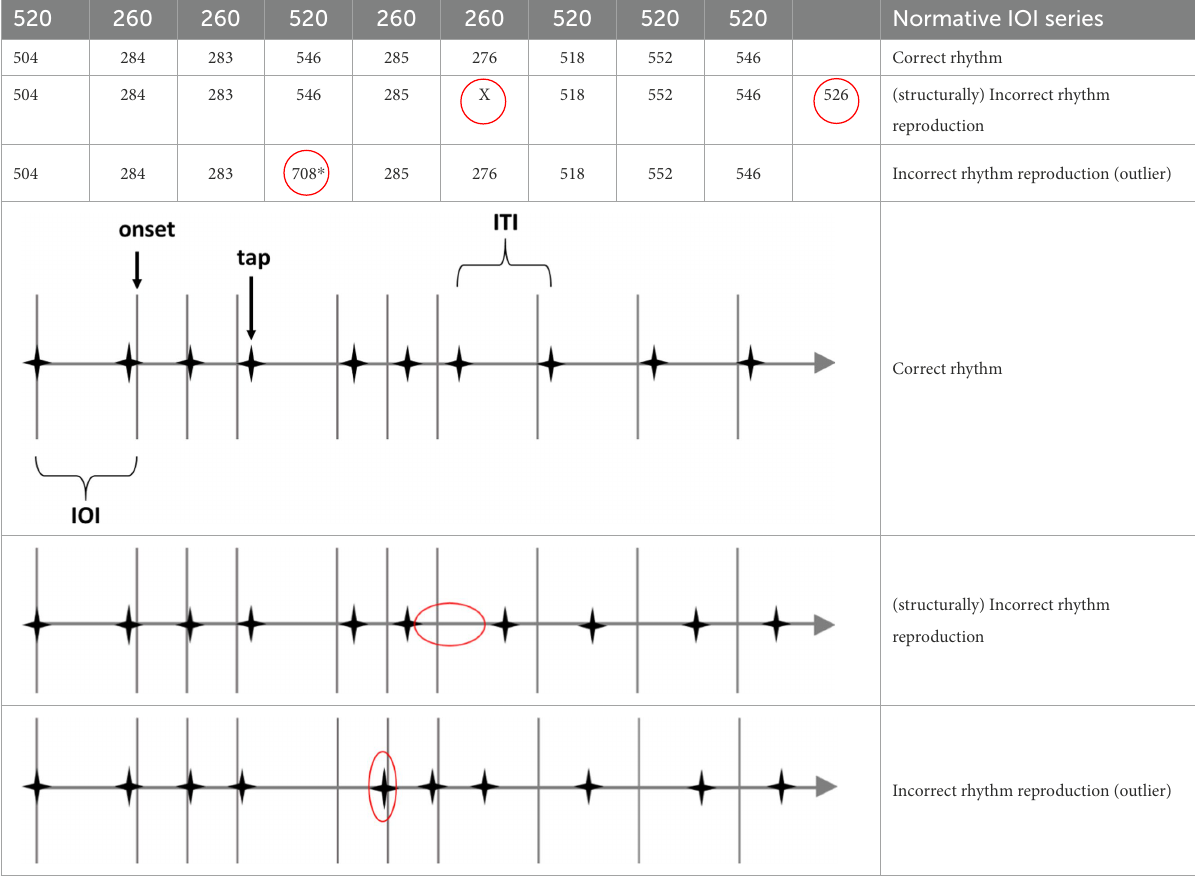
TABLE 2 Example for IOI series of a reference rhythm of the PROMS and three fictitious reproduction series, represented with millisecond values (upper part) and with a figure (lower part), to exemplify our approach to the assessment of rhythm tapping